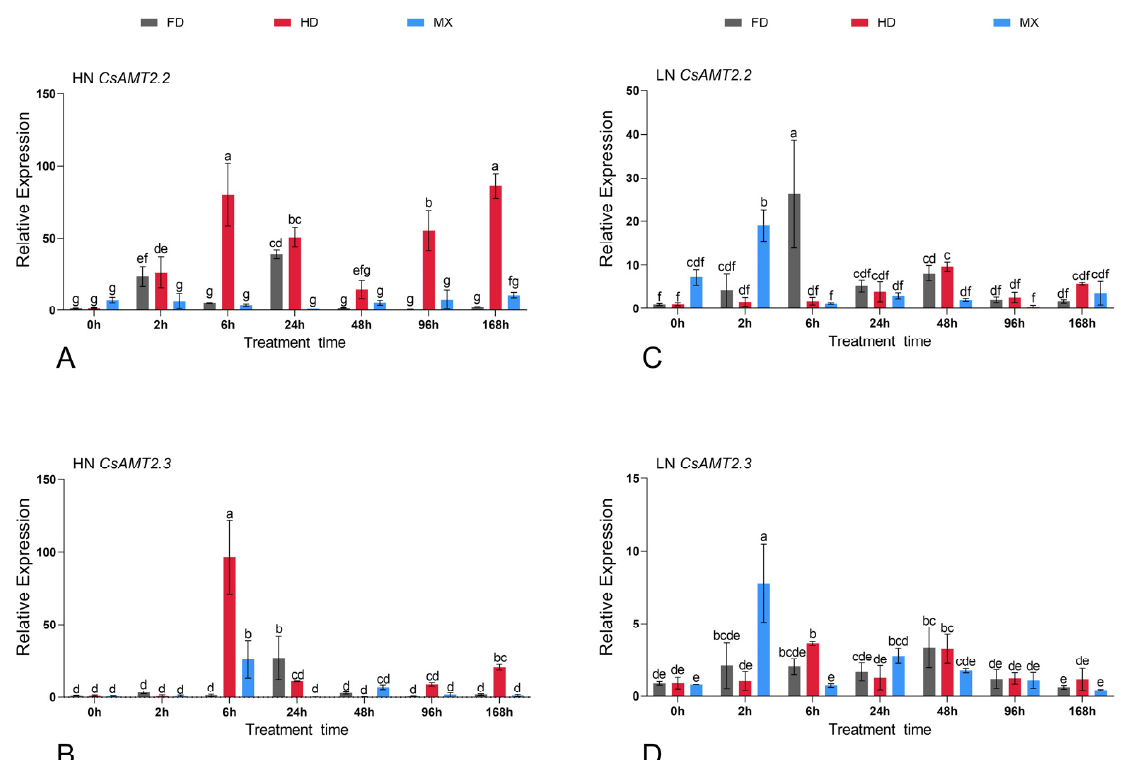
Figure 7. The temporal expression profiles of CsAMT2.2 ( A , C ) and CsAMT2.3 ( B , D ) in roots in response to high and low NH 4+ resupply treatments. Data shown are the means of three biological replicates ± standard deviation (SD). By using one-way analysis of variance (ANOVA) by Duncan, the lowercase letters represent significant differences at p < 0.05.